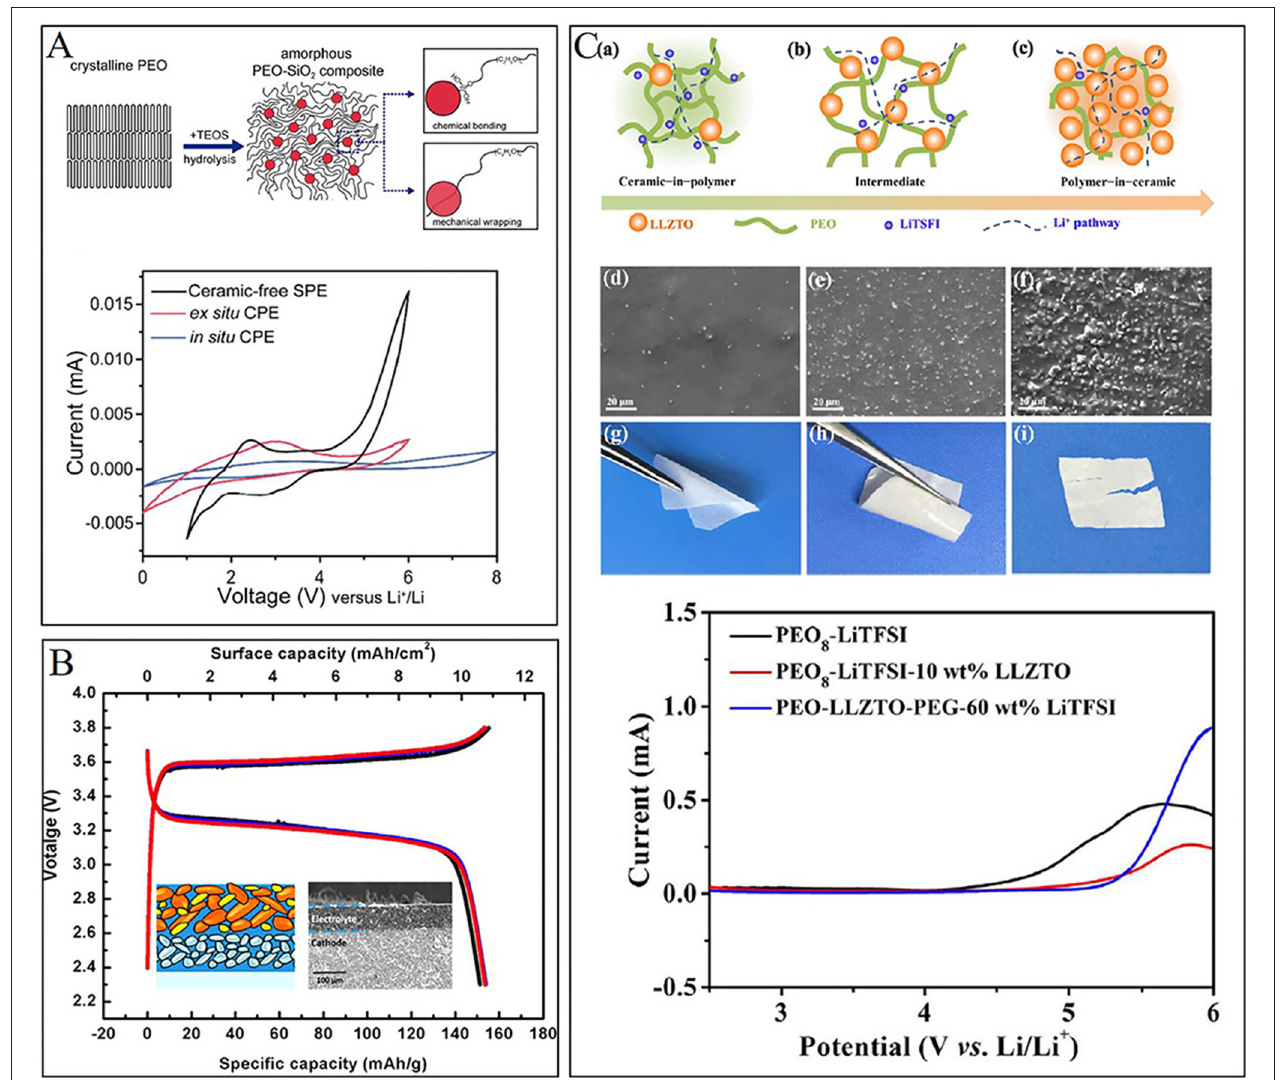
FIGURE 7 | (A) Schematic figures showing the procedure of in situ hydrolysis and interaction mechanisms among PEO chains and MUSiO 2 (up) and the electrochemical stability windows curves of three kinds of solid electrolyte. [Reprinted with permission from (Lin et al., 2016). Copyright (2016) American Chemical Society]. (B) The sketch map SEM image of the interface between Al-LLZTO/PEO composite cathode containing 15 wt% polymer and the composite electrolyte. The curves refer to first three galvanostatic charge and discharge curves. [Reprinted with permission from (Chen et al., 2018a). Copyright (2018) American